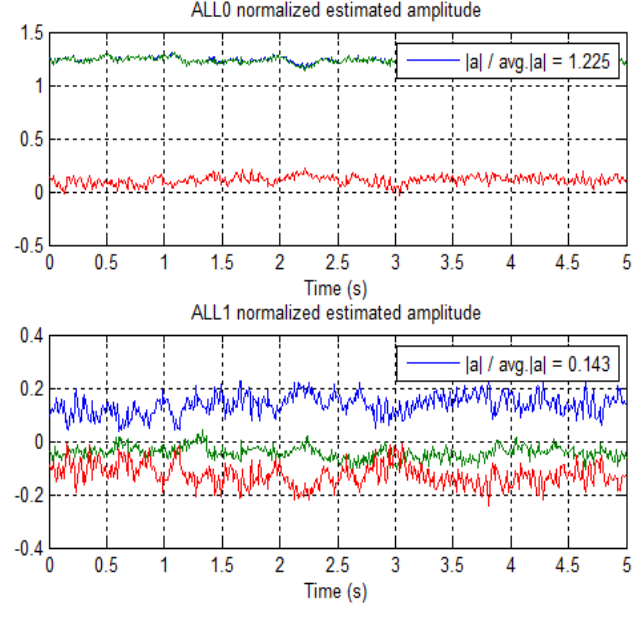
Figure 10. Estimated amplitudes by unit 0 (top) and unit 1 (bottom) in the time interval from 475 to 480